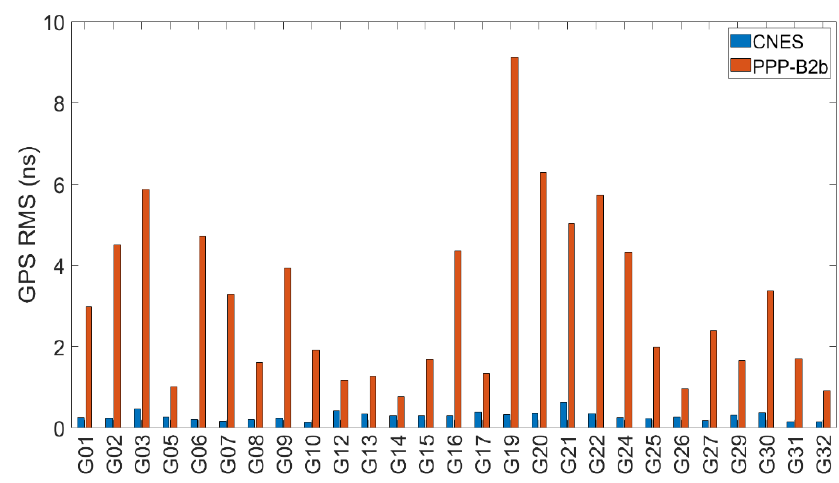
Figure 11. RMS values of GPS clock errors for the PPP-B2b and CNES products.